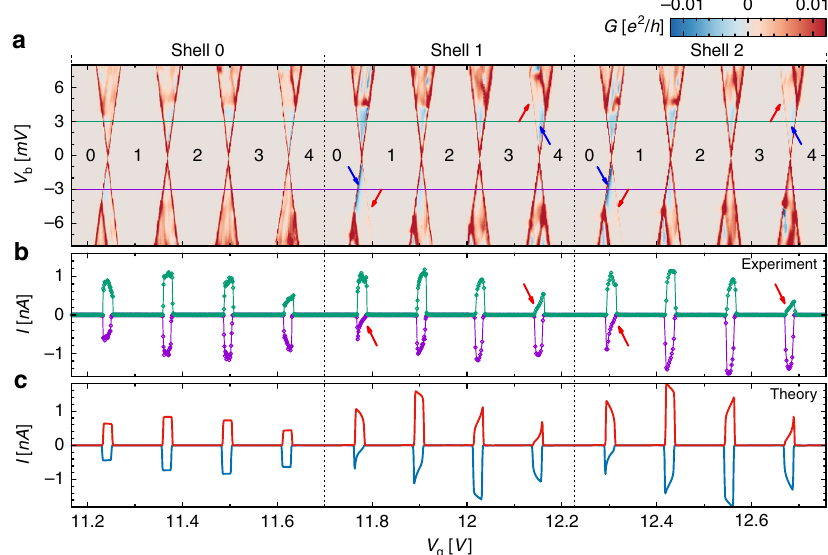
Fig. 2 Experimental signatures of coherent population trapping. a Experimental differential conductance as a function of back-gate voltage V g and bias voltage V b . Twelve consecutive Coulomb diamonds can be assigned to three carbon nanotube shells which get progressively occupied with N = 1 to N = 4 electrons. Current suppression (negative differential conductance) and faint Coulomb diamond borders are observed, indicated by blue and red arrows, respectively. b Current vs. gate voltage for the two values V b = ±3.045 mV of the bias voltages corresponding to the green/purple lines in panel ( a ). Solid lines provide here a guide to the eye. Current suppression associated to coherent population trapping is indicated by red arrows. c Numerically evaluated stationary current qualitatively reproducing the experiment. The parameters used in the simulation are shown in Table